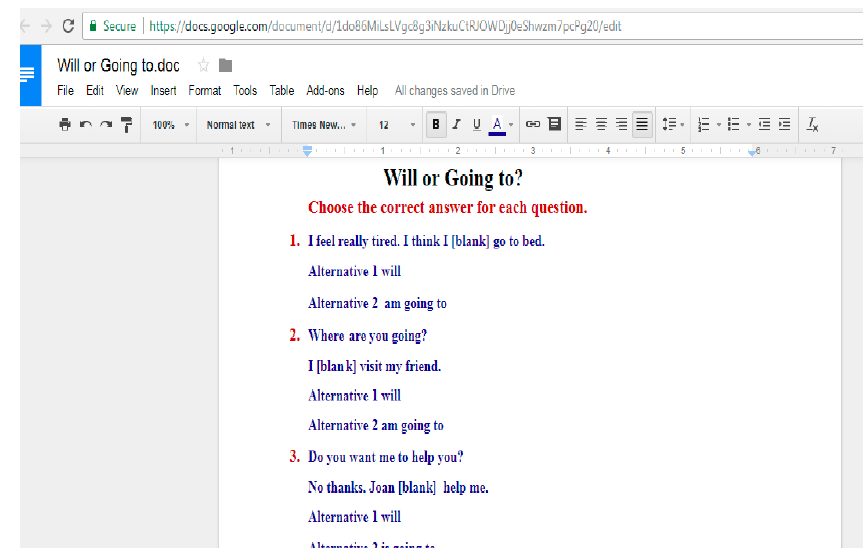
Figure 6. Adapted multiple-choice grammar exercise on Google Forms. Exercise conceived and written by Retorta.